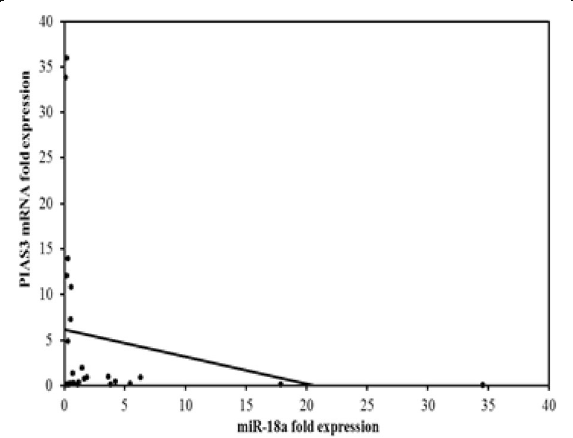
Fig. 3 Correlation between PIAS3 mRNA fold expression and miRNA-18a fold expression in the studied patients. Legend: r = 0.469, p =